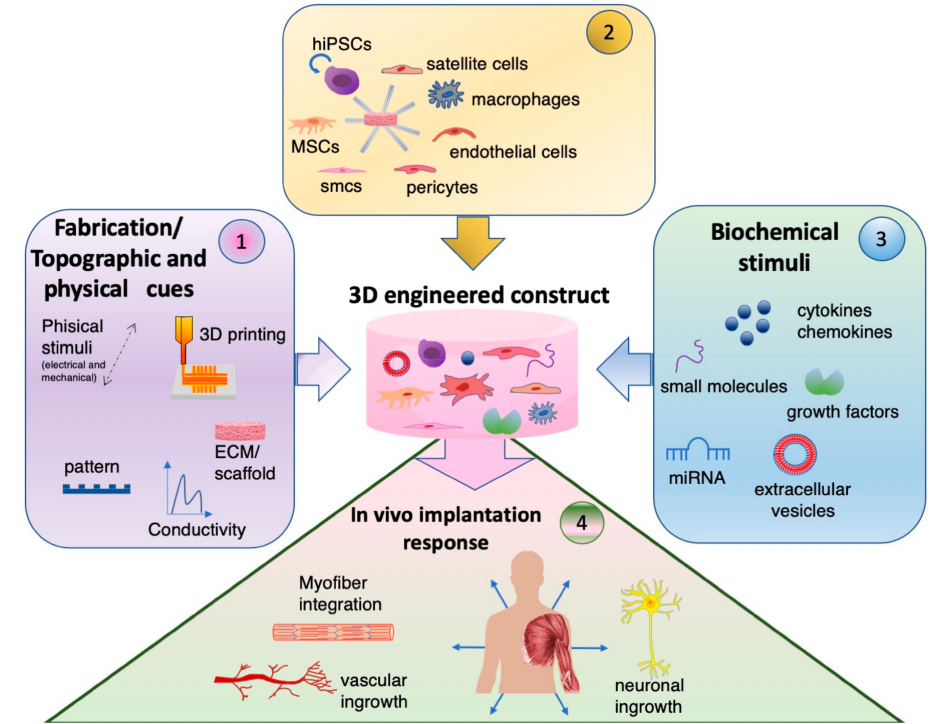
Figure 1. Next stage approach for muscle tissue engineering. The next-generation engineered tissues for muscle regeneration should combine (1) technology cues (fabrication / topographic and physical cues), (2) multiple cell types, and (3) biochemical factors. This complex, multi-cellular and multi-factorial construct is expected to support the de novo formation of the neuro-vascular cell compartment and functional myofiber integration upon in vivo implantation